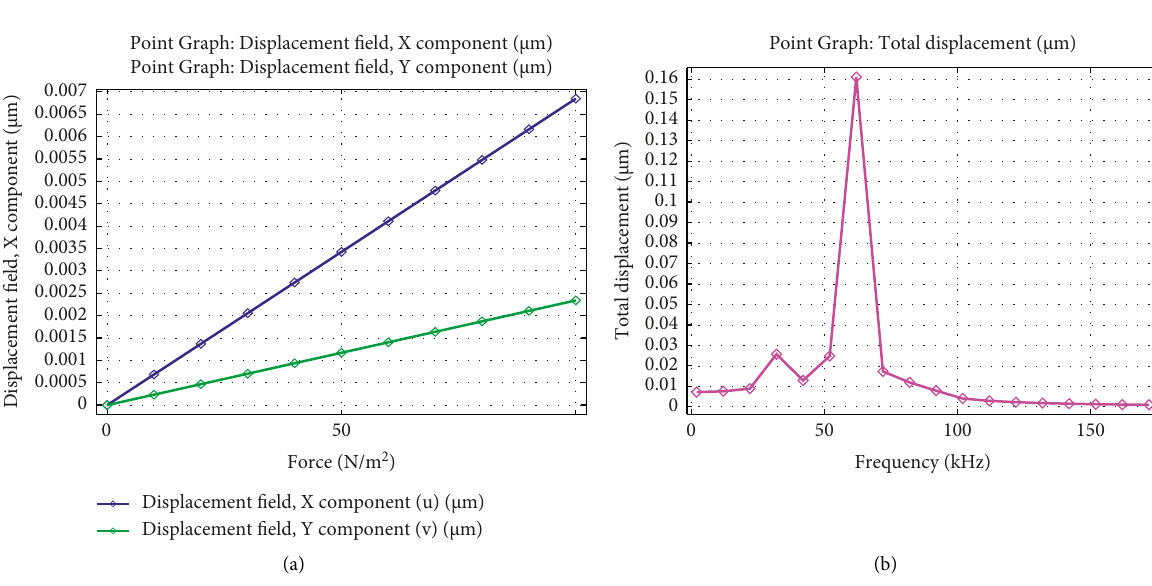
Figure 10: (a) Displacement characteristics; (b) natural frequency for the proposed sensor